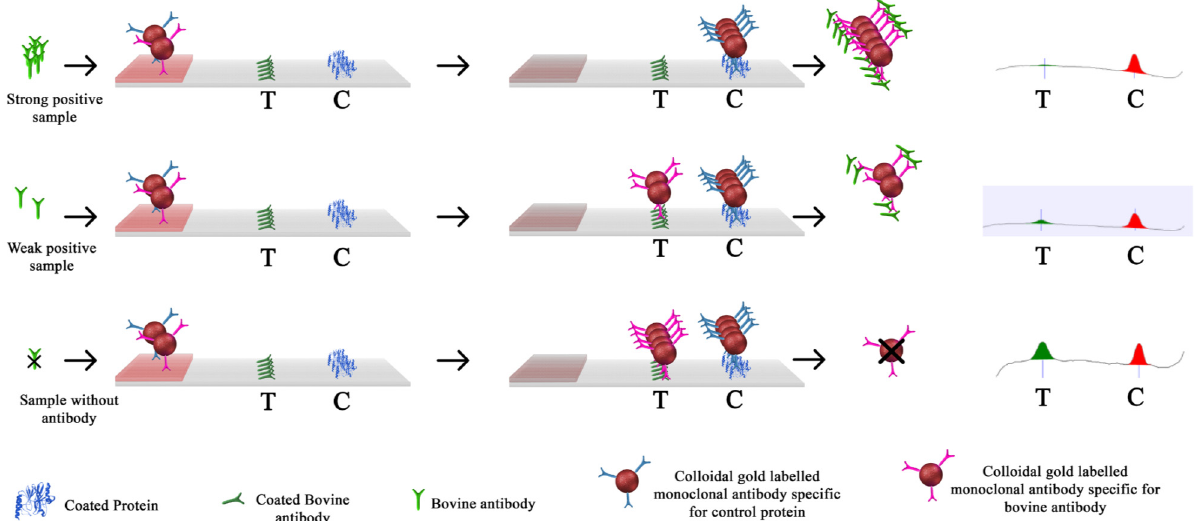
Figure 1. Schematic representation of the quick test (SmartStrips TM , Bio-X Diagnostics, Rochefort, Belgium) mechanism to estimate calf serum IgG concentration. T = test. C = control.